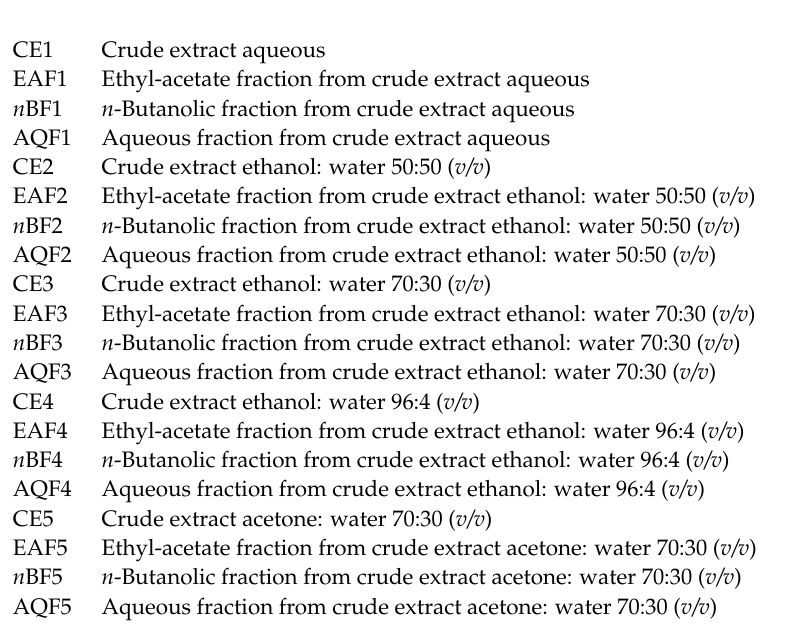
Table S4: Compounds identification of EAF2 and